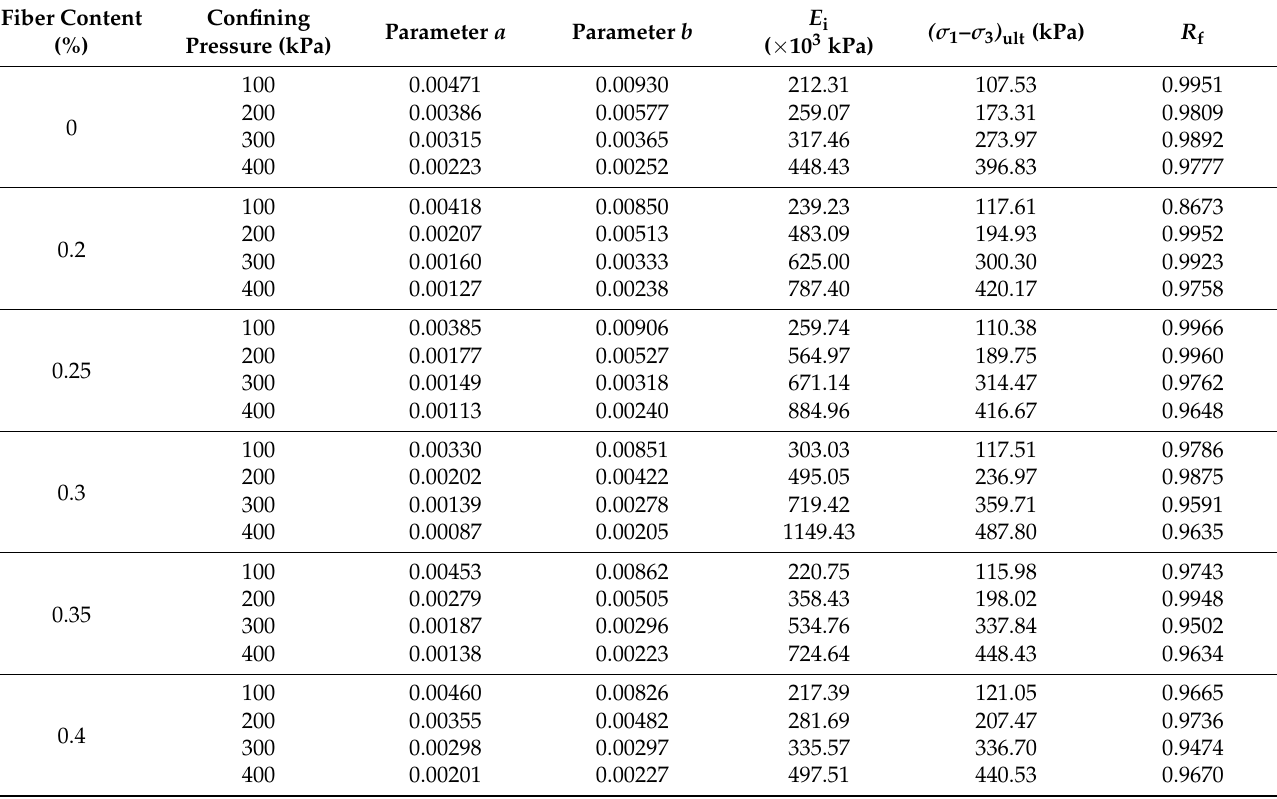
Table 3. Tangent deformation modulus and related